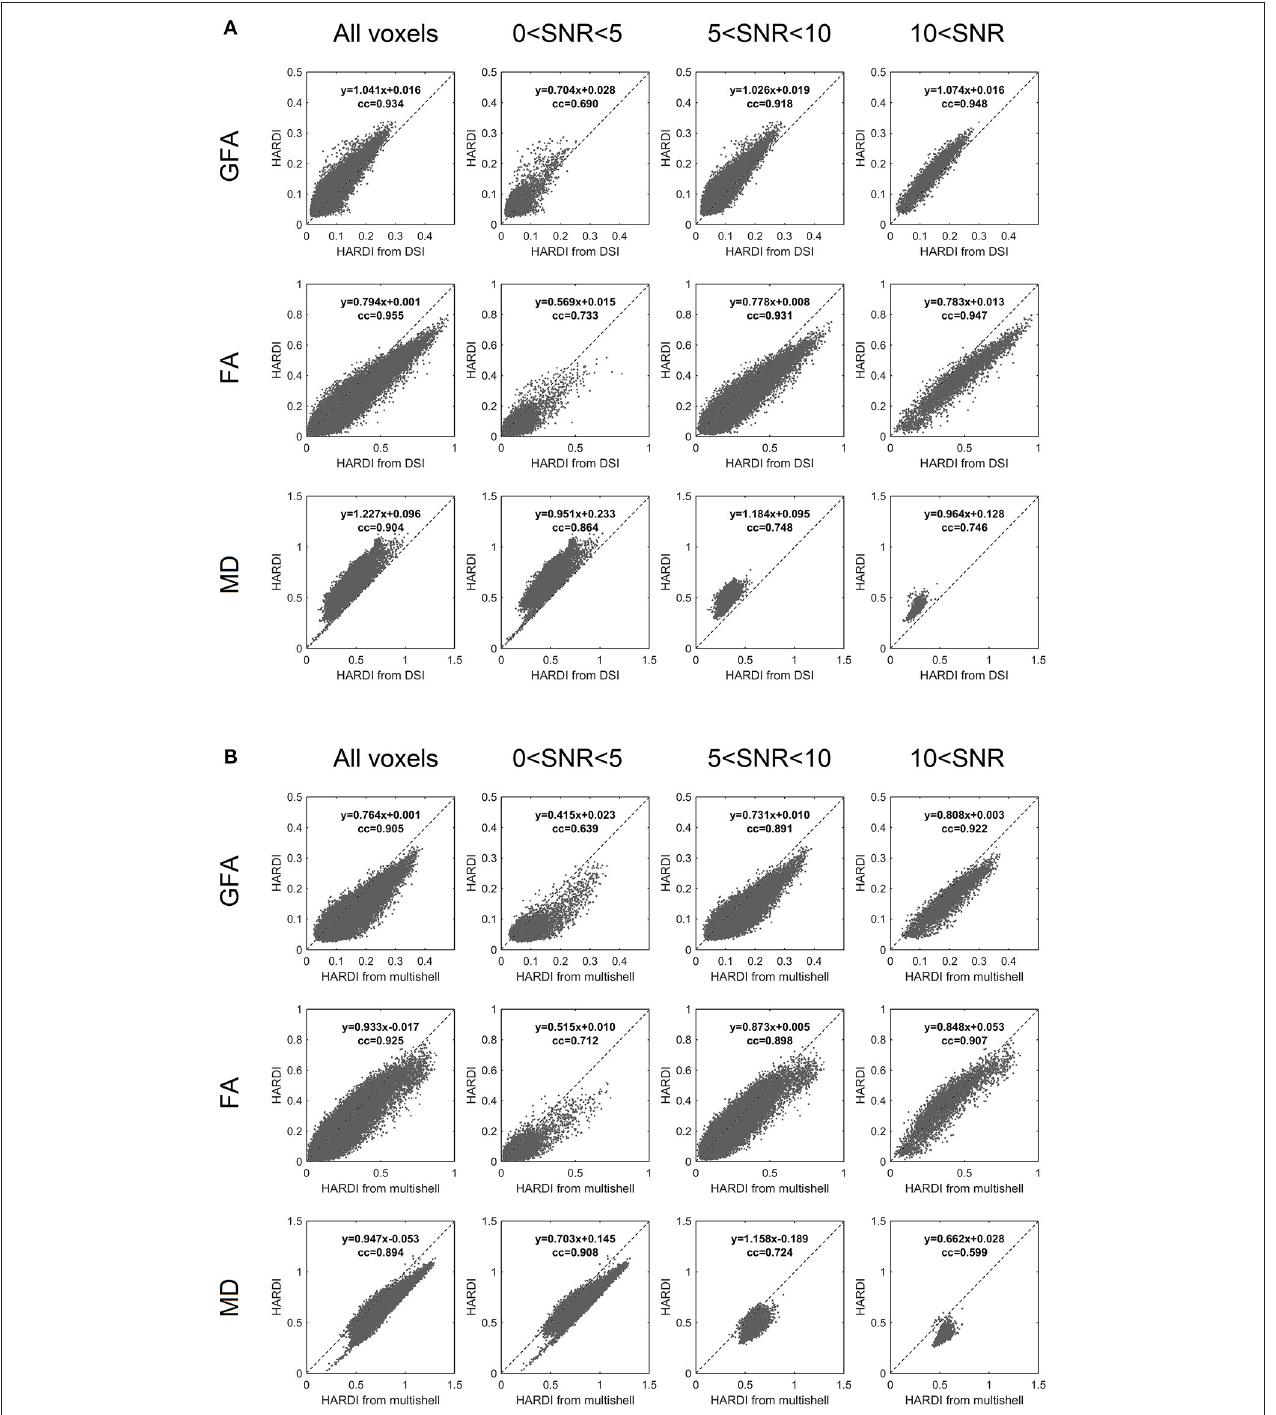
FIGURE 4 | GFA, FA, MD measurements between (A) HARDI converted from DSI and original HARDI and between (B) HARDI converted from multishell and original HARDI. The dotted lines indicate identity. The dotted lines indicate identity. identity. For both DSI and multishell schemes, the converted HARDI shows high correlation coefficients of GFA, FA, and MD around 0.9 with those of the original HARDI. The low SNR voxels also present moderate to good correlation, suggesting that HARDI converted from DSI and multishell can provide highly predictive GFA, FA, and MD measurements.